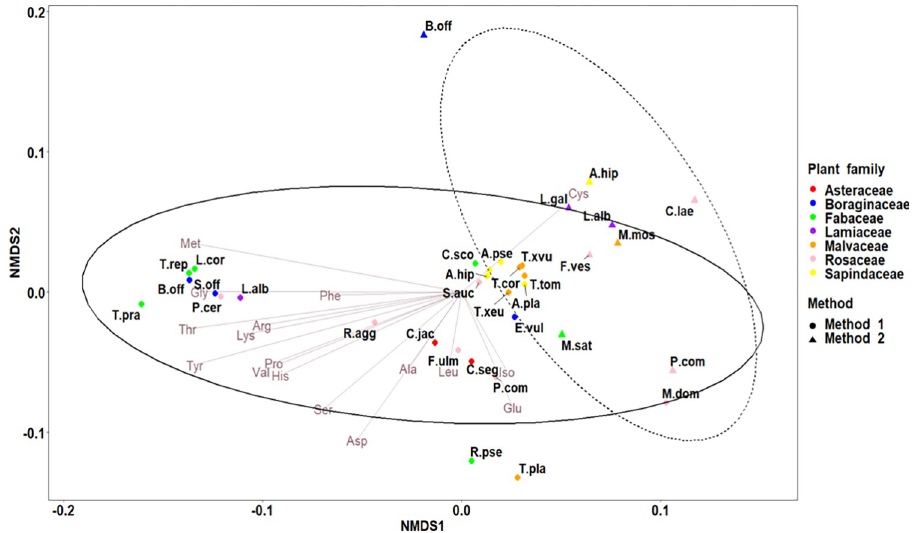
Fig 2. nMDS ordination plot based on Bray-Curtis distances calculated on amino acids contents (i.e., amounts in μ g/mg of amino acids) from pure floral pollen for each plant species (stress = 0.09). Method 1: IEX chromatography method; Method 2: HPLC method. The two ellipses gather species according to the analytical method used with solid lines for the IEX chromatography method and dashed lines for the HPLC method. Families are indicated in different colours. Amino acids: Ala, alanine; arg, arginine; asp, aspartic acid; cys, cysteine; glu, glutamine; gly, glycine; his, histidine; ile, isoleucine; leu, leucine; lys, lysine; met, methionine; phe, phenylalanine; pro, proline; ser, serine; thr, threonine; tyr, tyrosine; val, valine. Species: A.pla, Acer platanoides ; A.pse, Acer pseudoplatanus ; A.car, Aesculus carnea ; A.hip, Aesculus hippocastanum ; B.off, Borago officinali s; C.jac, Centaurea jacea ; C.lae, Crataegus laevigata ; C.seg, Cyanus segetum ; C.sco, Cytisus scoparius ; E.vul, Echium vulgare ; F.ulm, Filipendula ulmaria ; F.ves, Fragaria vesca ; L.alb, Lamium album ; L.gal, Lamium galeobdolon ; L.cor, Lotus corniculatus ; M.mos, Malva moschata ; M.dom, Malus domestica ; P.avi, Prunus avium ; P.cer, Prunus cerasus ; P.com, Pyrus communis ; R.pse, Robinia pseudoacacia ; R.agg, Rubus aggr .; S.auc, Sorbus aucuparia ; S.off, Symphytum officinale ; T.cor, Tilia cordata ; T.pla, Tilia platyphyllos ; T.tom, Tilia tomentosa ; T.xeu, Tilia x euchlora ; T.xvu, Tilia x vulgaris ; T.pra, Trifolium pratense ; T.rep, Trifolium repens